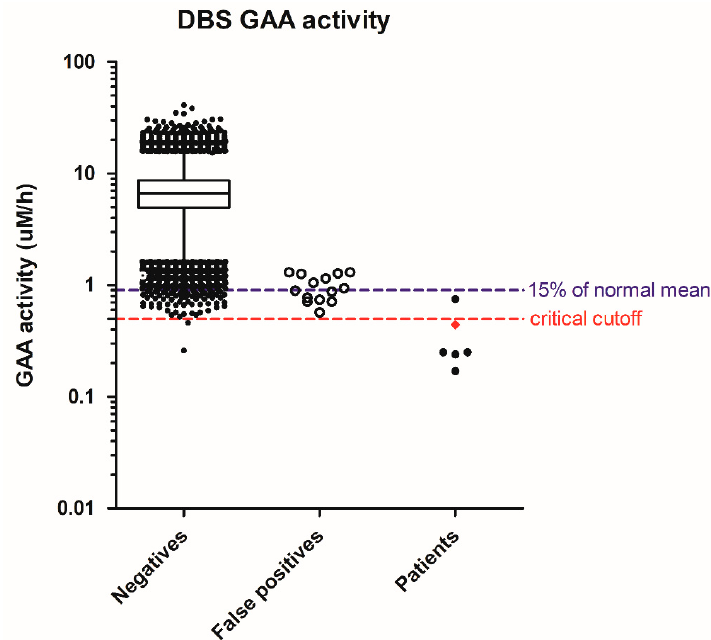
Figure 1. Distribution of screening acid α -glucosidase (GAA) activity in negatives, false positives, and patients. Whiskers: 1 – 99th percentile; box: 25 – 75th percentile; line in box: median; diamond in patients: IOPD; solid dots in patients: suspect LOPD.